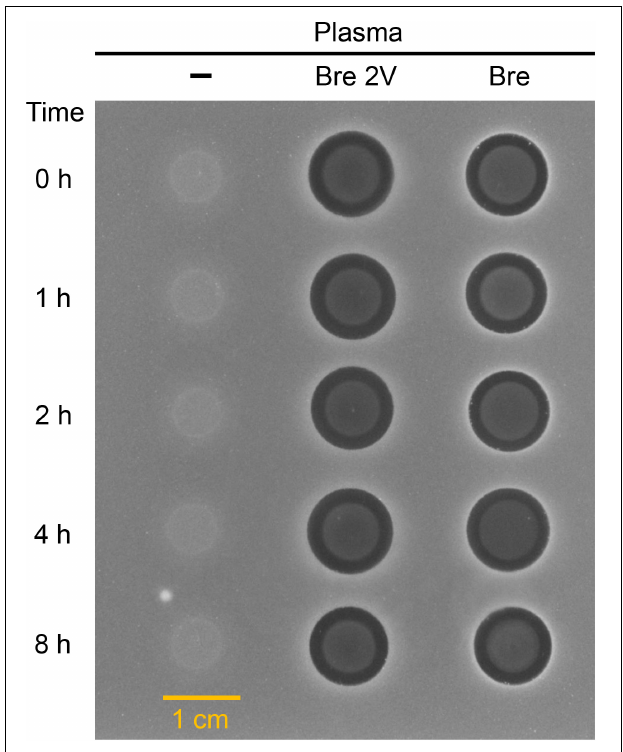
FIGURE 4 | Antimicrobial activity of brevibacillin 2V brevibacillin against Staphylococcus aureus (MRSA) after exposure to human plasma. The starting concentration was 200 mg/L for both brevibacillin 2V and brevibacillin. Samples were collected at 0, 1, 2, 4, and 8 h, and 6 µ l of each sample was loaded to a square plate containing S. aureus (MRSA). Bre 2V, brevibacillin 2V; Bre,